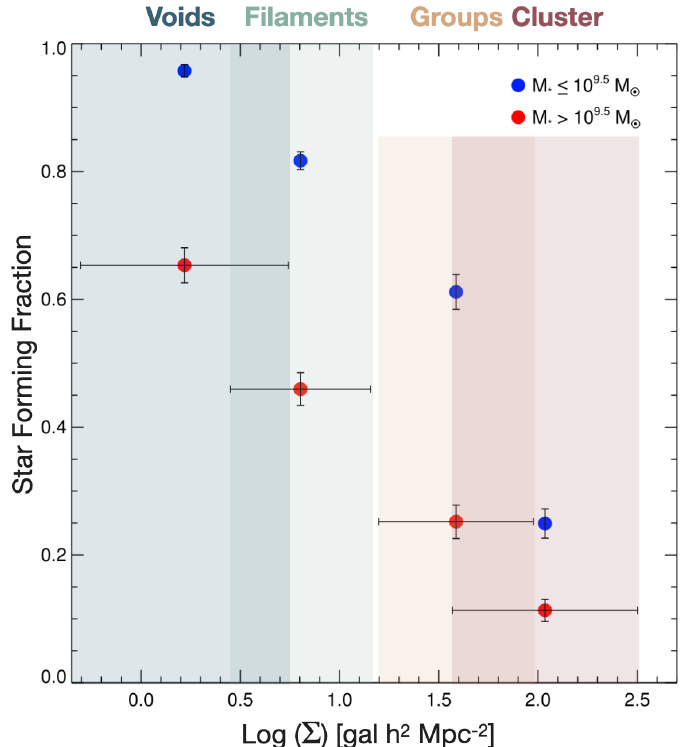
Figure 1. The star-forming fraction across four environments (voids, filaments, groups, and the cluster) in the Coma Supercluster region. Two stellar mass bins are shown: log M (cid:63) / M (cid:12) ≤ 9.5 (blue) and log M (cid:63) / M (cid:12) > 9.5 (red). At all masses, the star-forming fraction progressively decreases with increasing local galaxy density. Note that the star-forming fraction for low-mass galaxies in underdense void regions is nearly one. Horizontal error bars indicate the standard deviation of each local density bin (omitted from the lower mass bin for clarity). Figure adapted from Figure 9 in Cybulski et al.